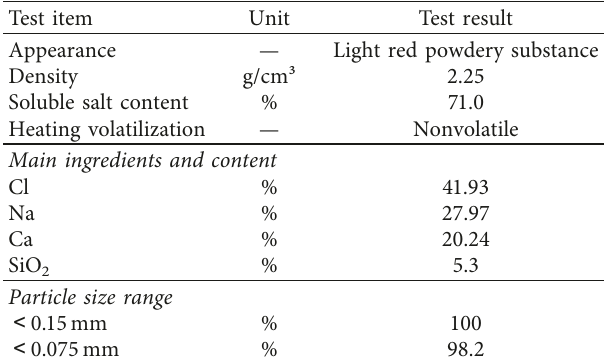
Table 1: MFL basic